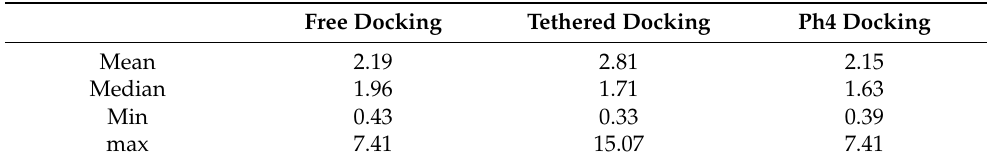
Figure 3. Differences in best pose predicted for target 5p8y from CELPP week 33. Image ( A ) corresponds to free docking with an RMSD of 4.09 Å. Image ( B ) is the best prediction obtained with pharmacophoric restraints (1.74 Å). Image ( C ) corresponds to the best pose using tethered docking, obtaining an RMSD of 0.95 Å. The red substructure indicates the tethered atoms. Table 1. RMSD results obtained using different docking